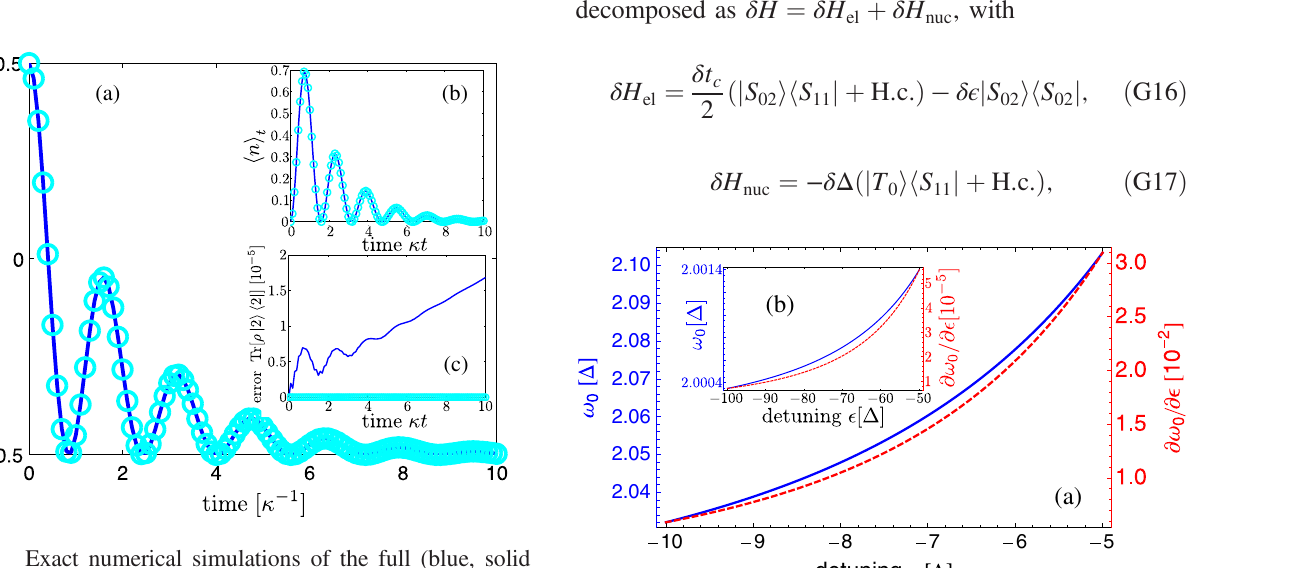
FIG. 12. Exact numerical simulations of the full (blue, solid line) and approximate (cyan circles) master equations as given in Eqs. (G14) and (G15), respectively. Plots are shown for (a) the FIG. 13. Transition frequency ω 0 (blue solid line) and its electronic inversion h S z i , (b) the cavity occupation h n i , and t t sensitivity against charge-noise-induced fluctuations in ϵ for (c) the error Tr ½ ρ j 2 ih 2 j(cid:2) quantifying the leakage to j 2 i . The latter (a) intermediate and (b) large negative detuning; for large ¯ δ is found to be negligibly small ∼ 10 − 5 . We set ¼ ω 0 − ω c ¼ 0 . negative detuning, ω 0 ≈ 2 Δ , and the sensitivity ∂ ω 0 = ∂ ϵ practi- 10 μ eV, ϵ ¼ − 7 μ eV, Δ ¼ 1 μ eV, Numerical parameters are t c ¼ cally vanishes, leaving nuclear noise as the dominant dephasing 4 × 10 − 3 μ eV ≈ η e φ 0 ¼ 5 . 2 × 10 − 2 μ eV, such that g process. By occasional refocusing of the spin states, this regime geo QD ¼ 6 MHz. The cavity decay rate is κ ¼ g = 2 , corresponding can be used for long-term storage of quantum information [69]. QD 5 Δ Other numerical parameters: t c ¼